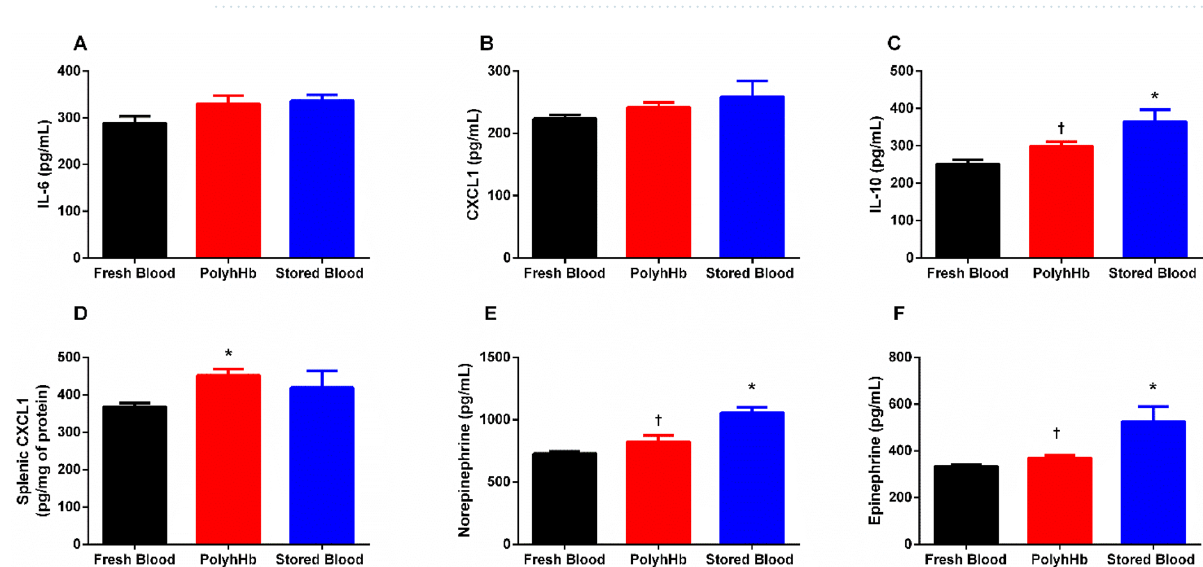
Figure 5. Systemic inflammation, splenic inflammation, and catecholamines. Neither PolyhHb or stored blood presented higher systemic inflammation compared to fresh blood (the gold standard for resuscitation). However, stored blood increased catecholamine levels compared to fresh blood and PolyhHb suggesting higher sympathetic activation after resuscitation. ( A ) Interleukin-6 (IL-6); ( B ) Chemokine ligand 1 (CXCL-1); ( C ) Interleukin-1(IL-10); ( D ) Splenic CXCL-1; ( E ) Norepinephrine; ( F ) Epinephrine. Measurements were taken 24 h after resuscitation. *, p < 0.05 versus Fresh Blood; †, p < 0.05 versus Stored Blood. Statistical comparisons were completed using a one way—ANOVA; Tukey’s multiple comparison